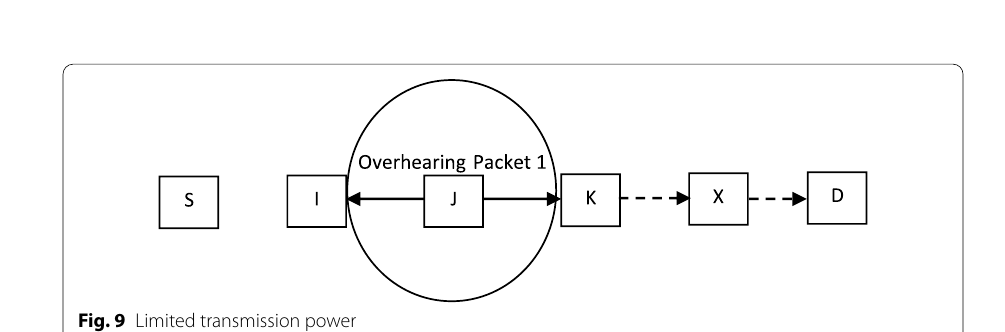
Fig. 8 Receiver collisions